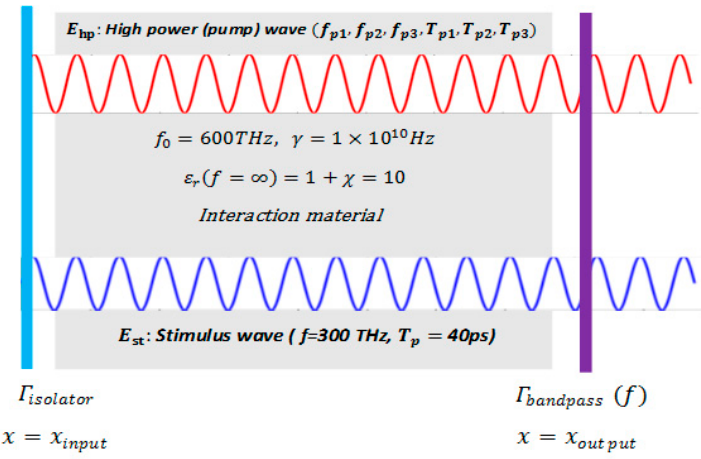
Figure 7. Configuration of the cavity and the parameters for Section 6.2.